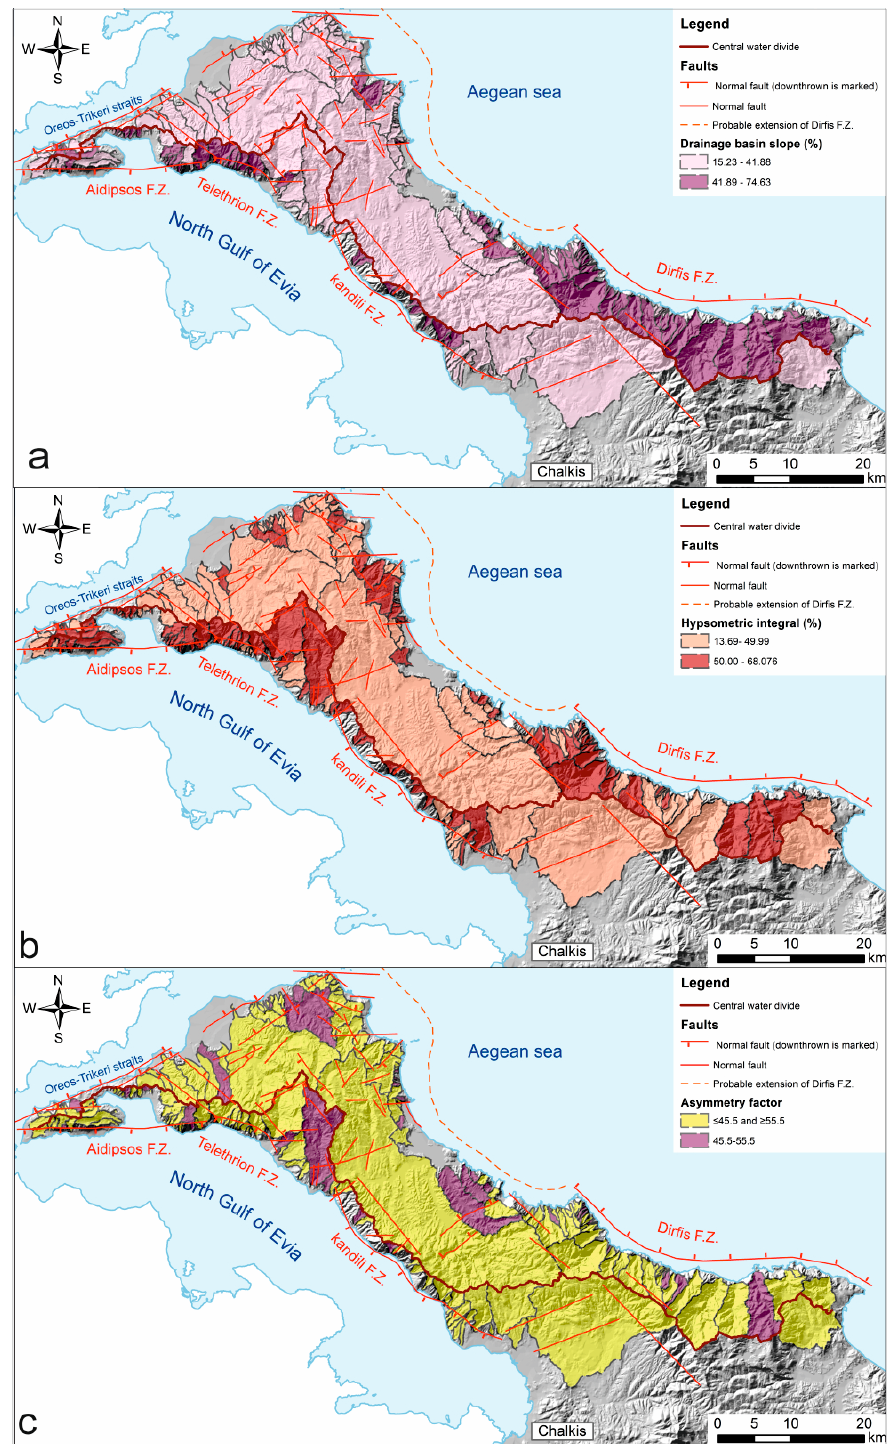
Figure 3. Spatial distribution of ( a ) Drainage Basin Slope, (S b ) ( b ) Hypsometric Integral (H i ), and ( c ) Asymmetry Factor (A f ).